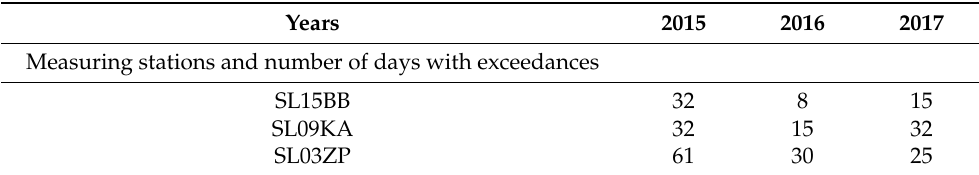
Table 3. Exceedances of the target level of ozone (maximum daily 8-h mean equal to or more than 120 µ g/m 3 ) in period 2015–2017—number of days.